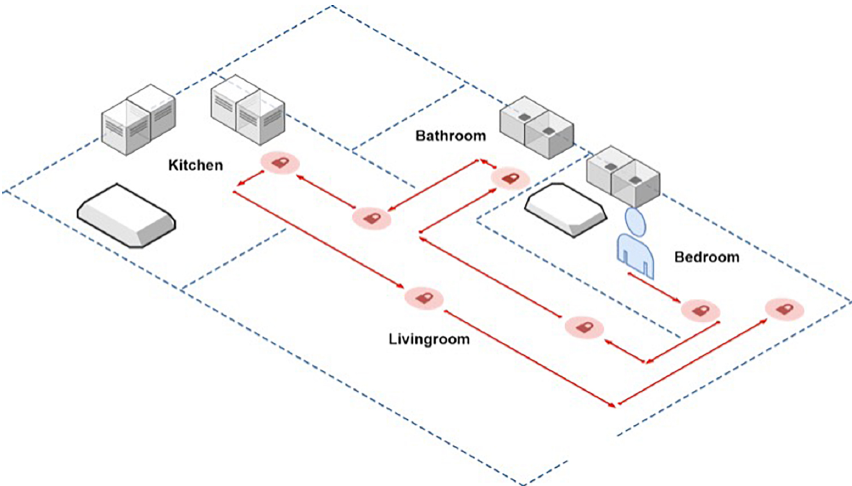
Figure 3. The test environment with the established path and